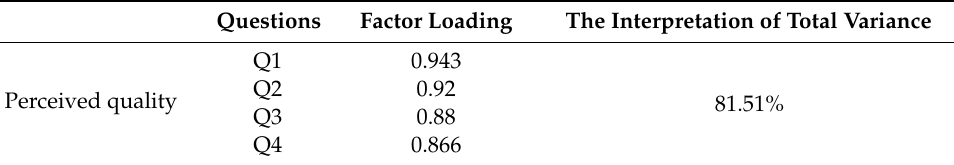
Table 7. The factor loading and the interpretation of total